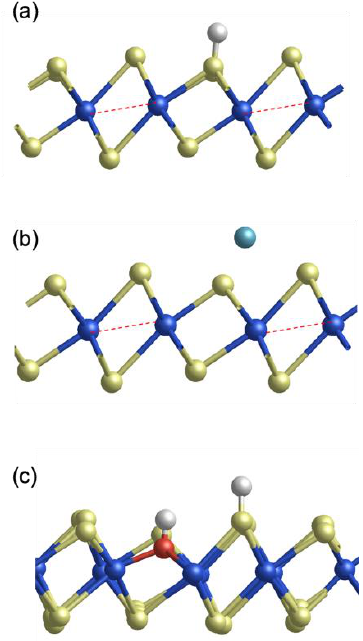
Figure 11. Side views of the relaxed atomic configurations of 1T-MoS 2 surfaces with different adsorbates: ( a ) H atom, ( b ) Li atom, and ( c ) H 2 O molecule, interacting with a sulfur vacancy [62].